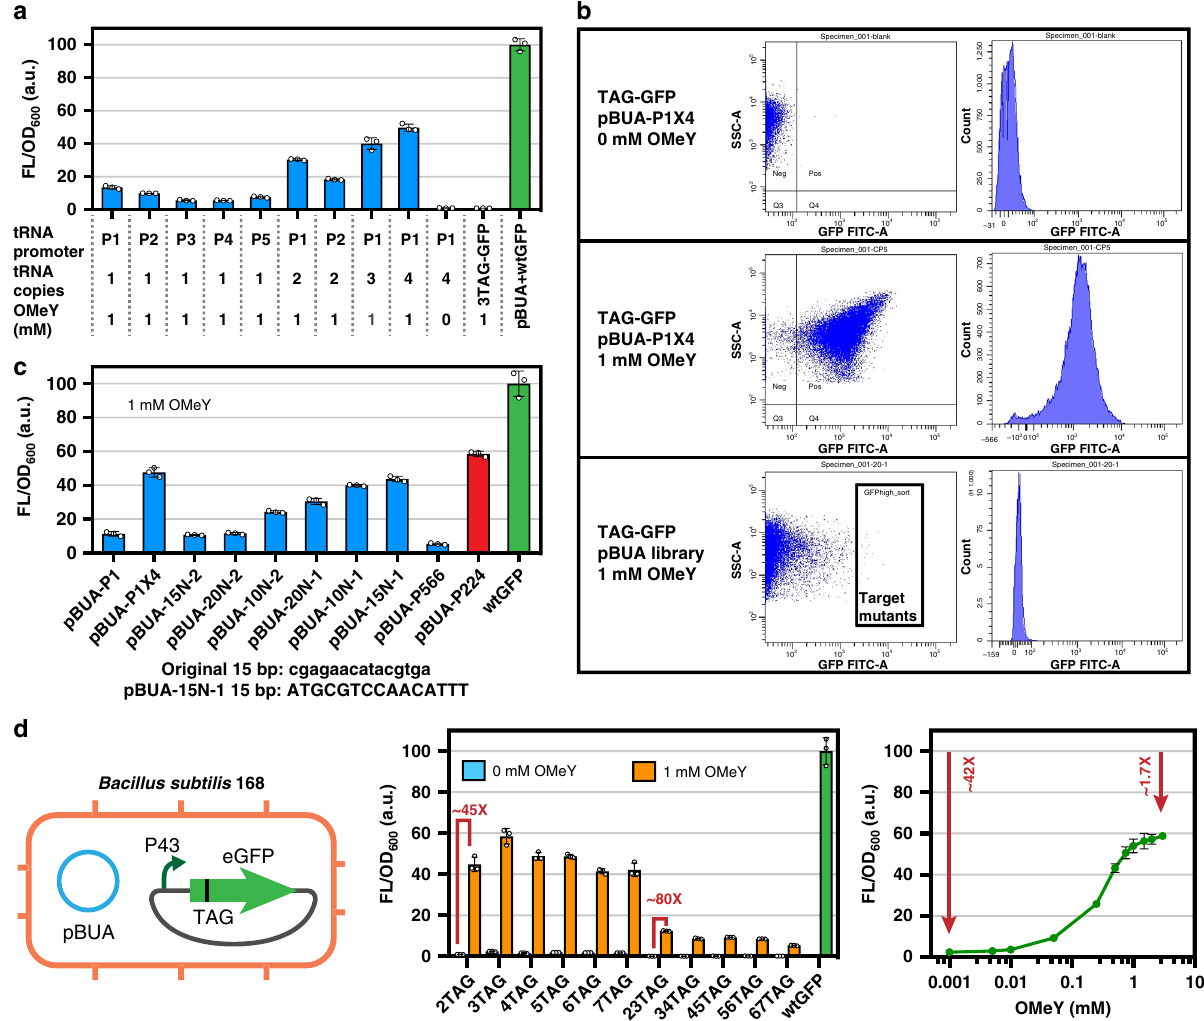
Fig. 3 Construction and optimization of Bacillus subtilis non-canonical amino acid (ncAA) incorporation tools. a Optimization of tRNA promoter and copy number. b Screening of three random mutant libraries for ef fi cient pBUA mutants using fl ow cytometry. SSC-A: granularity, FITC-A: GFP fl uorescence. c Degree of GFP expression level recovery by ef fi cient pBUA mutants obtained from three random mutant libraries, harboring pBUA constructs with synthetic promoters. d Ef fi ciency veri fi cation of pBUA in B. subtilis . The histogram (left panel) represents the degree of GFP expression recovery after replacing one or two original codons with amber stop codons in the sequence from the second to the seventh codon (2TAG to 7TAG and 23TAG to 67TAG). The line graph (right panel) shows the use of the 3TAG GFP gene to test GFP expression levels in the presence of different concentrations of p -acetyl-L-phenylalanine (pAcF). All the data are expressed as the mean ± SD from three ( n = 3) biologically independent replicates. Source data underlying ( a ), ( c ), ( d ) are provided as a Source data fi